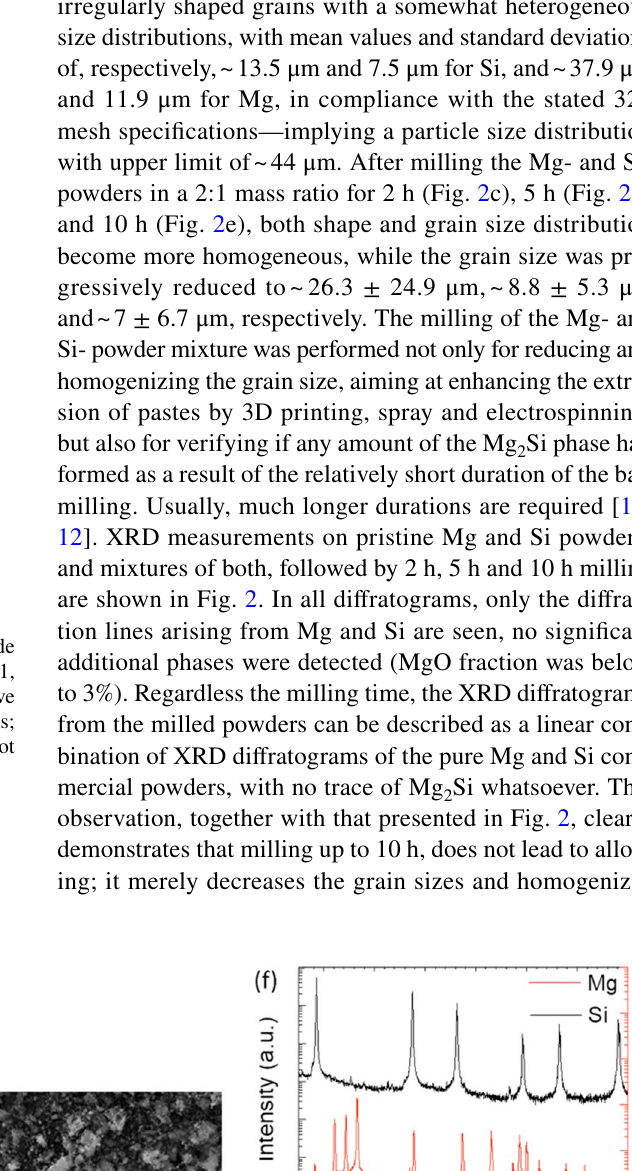
diffratograms of the starting Si and Mg powders (top) and the milled powders (bottom) are shown in ( f